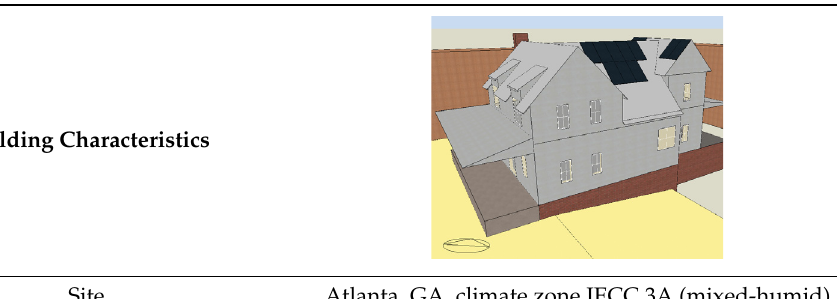
Table 6. Planning characteristics of building C. Source: architectural drawing [42].